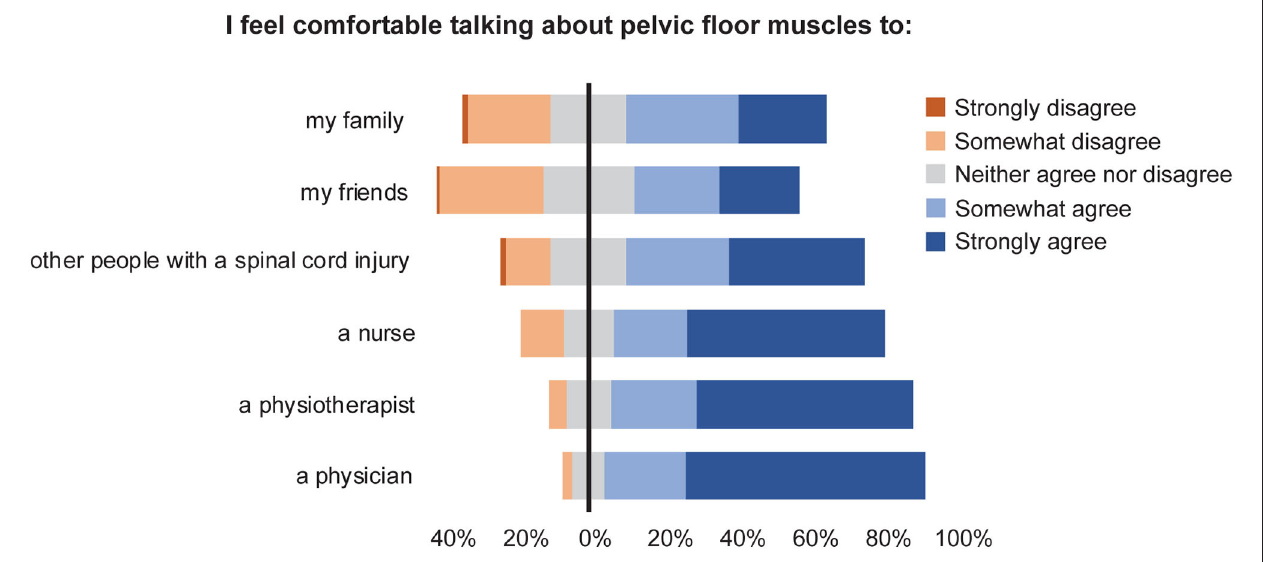
Frontiers in Rehabilitation Sciences |